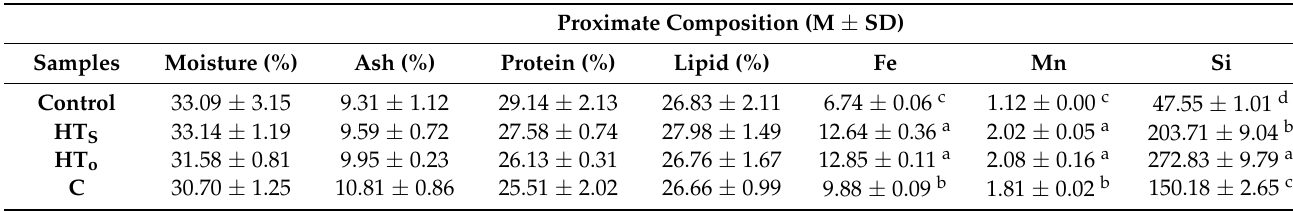
Table 2. Proximate composition and mineral content of fuet samples.